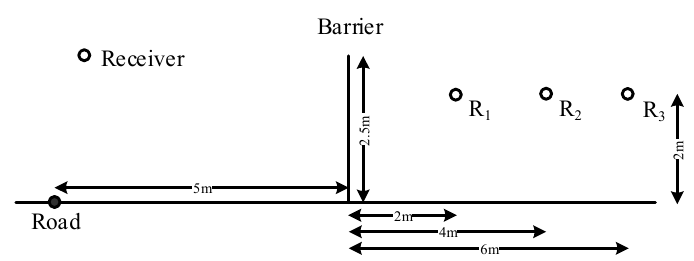
Figure 6. A case of noise calculation behind a road sound barrier.